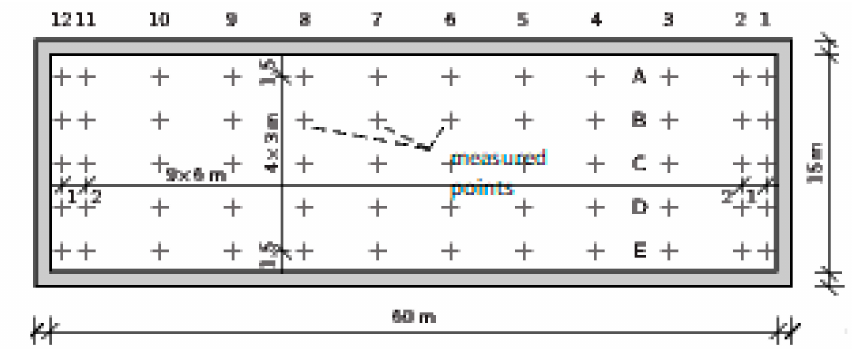
Figure 4. The floorplan of the